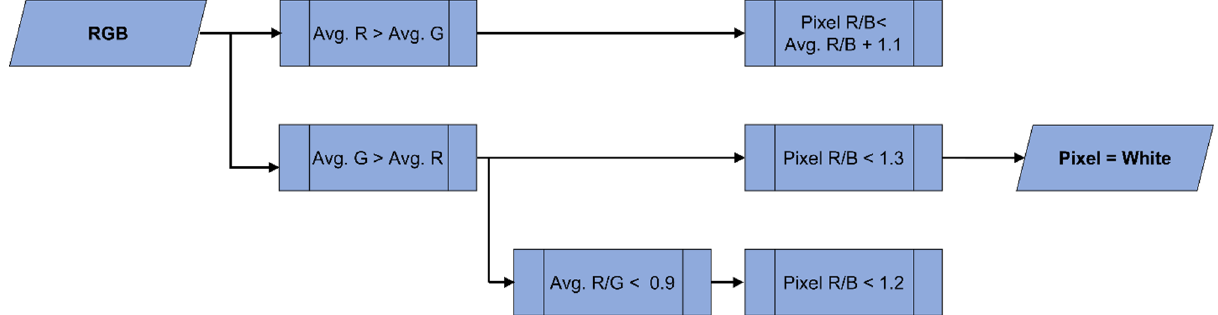
Figure 5. Workflow of step 3: Red (R), Green (G) and Blue (B) pixel values are used to extract the rest of the pixels that were not found in step 1 and